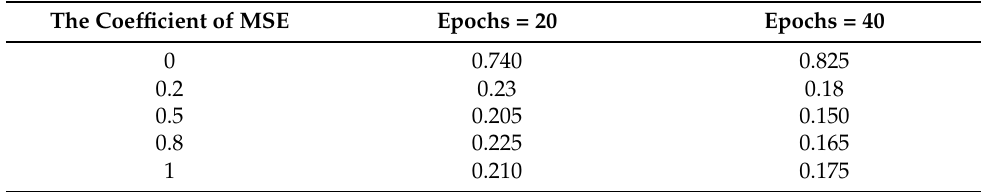
Table 4. Service quality loss rate of different expressions.